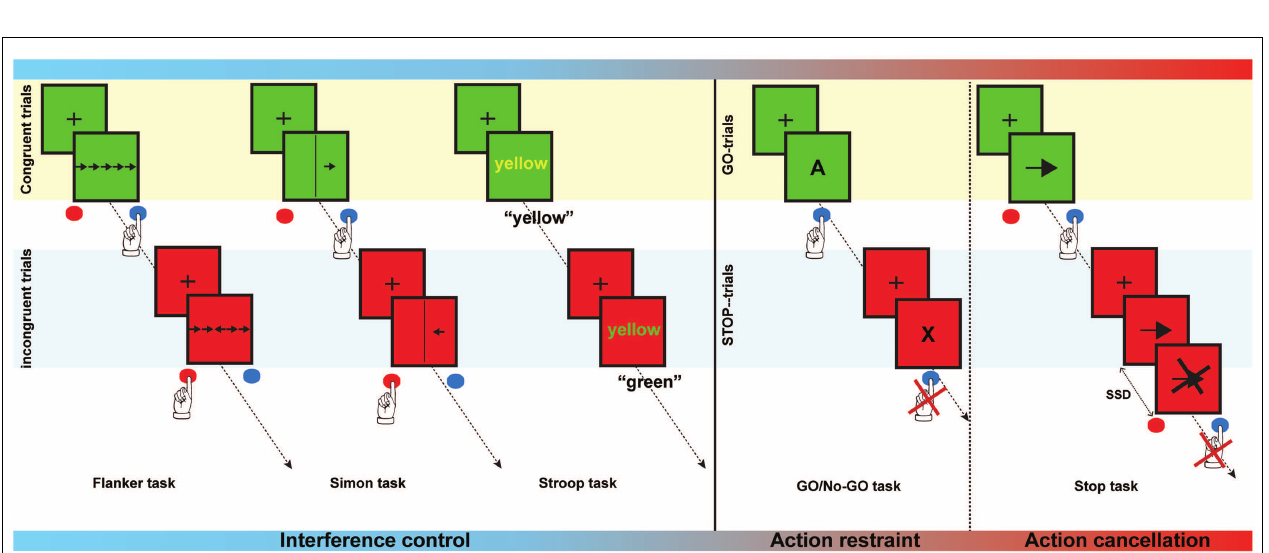
FIGURE 1 | Examples of interference control and motor response inhibition tasks .The Flanker task is a test in which subjects are asked to respond to a target stimulus by pressing a button to indicate the direction of the target stimulus.The target, however, is flanked by non-target distracter stimuli, which are presented in the same or in the opposite direction as the target (congruent and incongruent trials, respectively). During a Simon task , participants are asked to press a button depending on the orientation of the arrow, irrespective of the location of the arrow. Orientation and location can either be congruent of incongruent. In the Stroop task names of colors are presented in either the same (congruent)